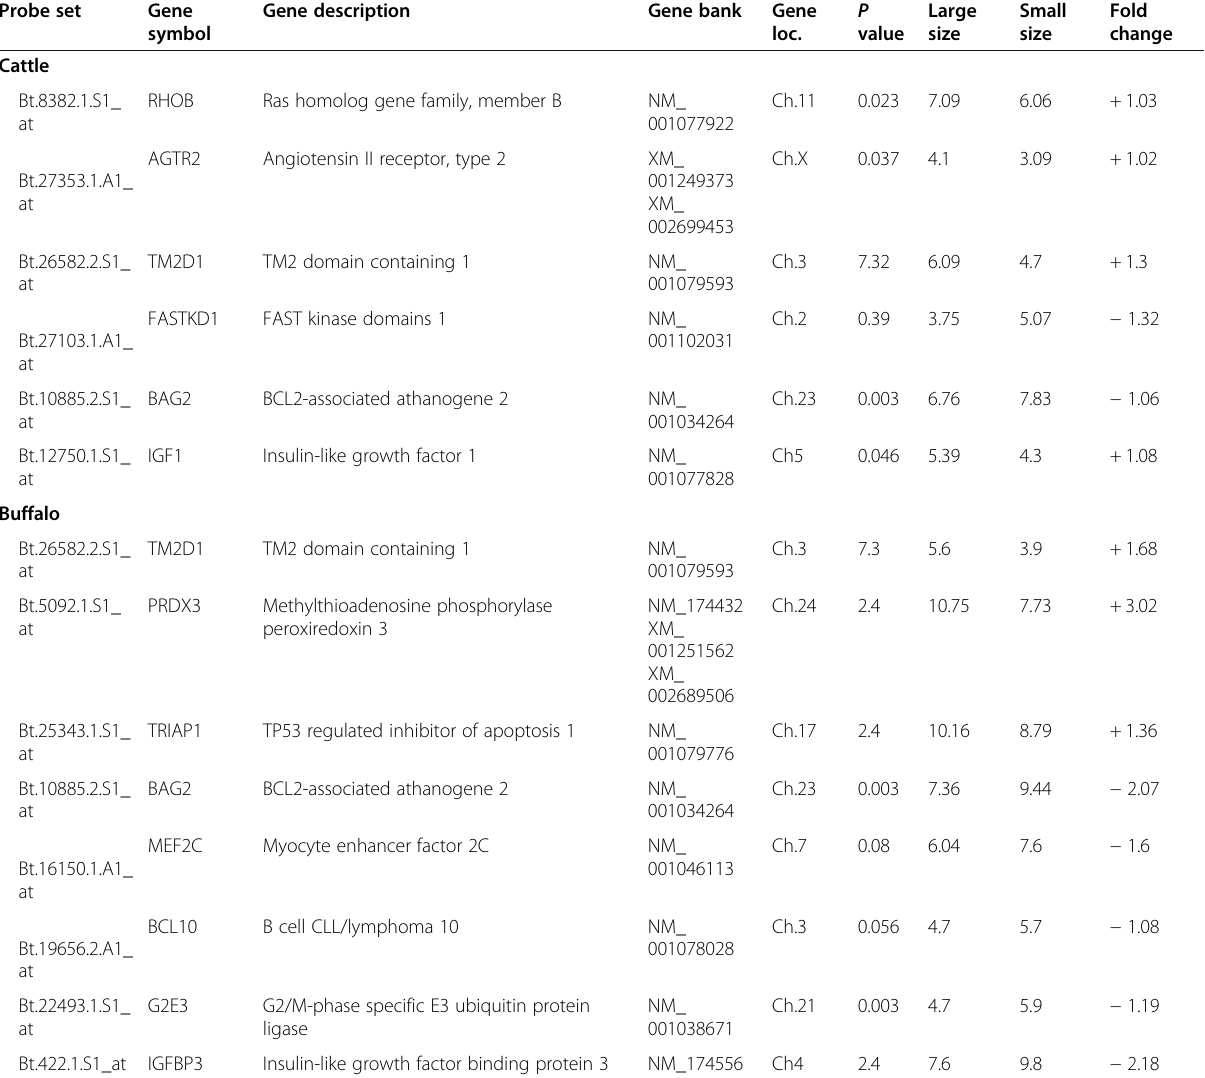
Table 3 Microarray data show description and fold changes for some genes of study Probe